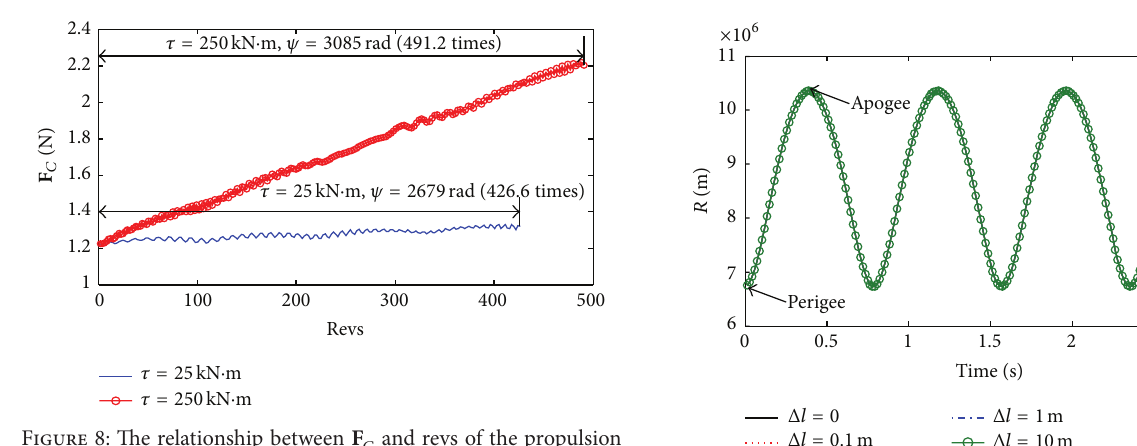
Figure 8: The relationship between F 𝐶 and revs of the propulsion tether with Δ𝑙 = 0.1 m and different 𝜏 .